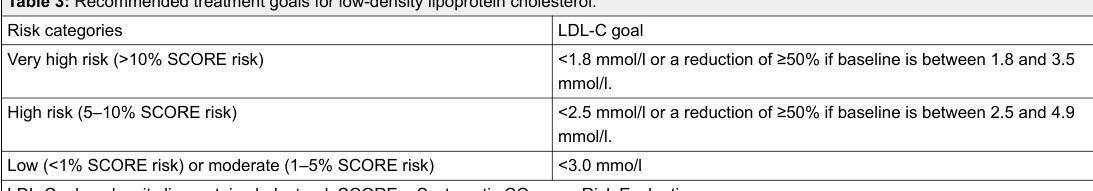
Table 3: Recommended treatment goals for low-density lipoprotein cholesterol. Risk